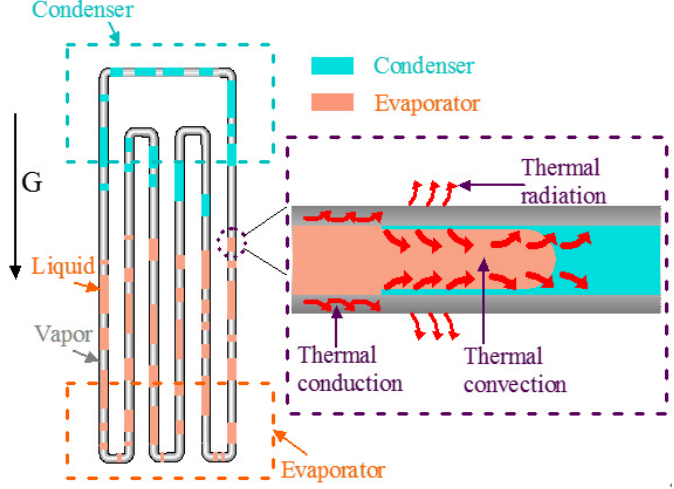
Figure 1. The working process of PHP. (The orange colour is the bubbles in evaporation section. The light blue colour is the bubbles in condenser section. The red colour is heat transmission).